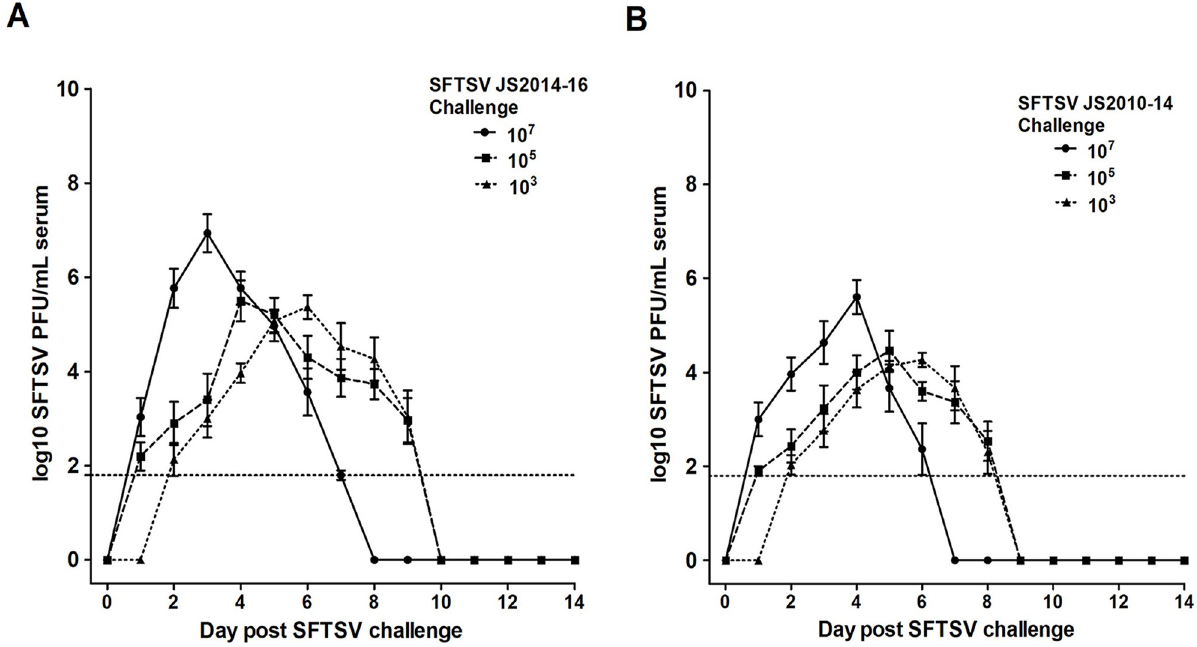
Fig 1. Experimental infection of spotted doves with two SFTSV strains. Error bars represent standard error of the mean log 10 PFU/mL of serum. The horizontal dashed line indicates a limit of detection of 10 1.8 PFU/mL. A: Spotted Doves inoculated with 10 7 plaque forming units (PFU) of SFTSV strain JS2014 (solid line) had higher mean viral loads that peaked earlier than did birds inoculated with 10 5 (dashed line) or 10 3 PFU (fine dashed line) of virus. B: Spotted doves inoculated with 10 7 plaque forming units (PFU) of SFTSV strain JS2010 (solid line) had higher mean viral loads that peaked earlier than did those birds inoculated with 10 5 (dashed line) or 10 3 PFU (fine dashed line) of virus.